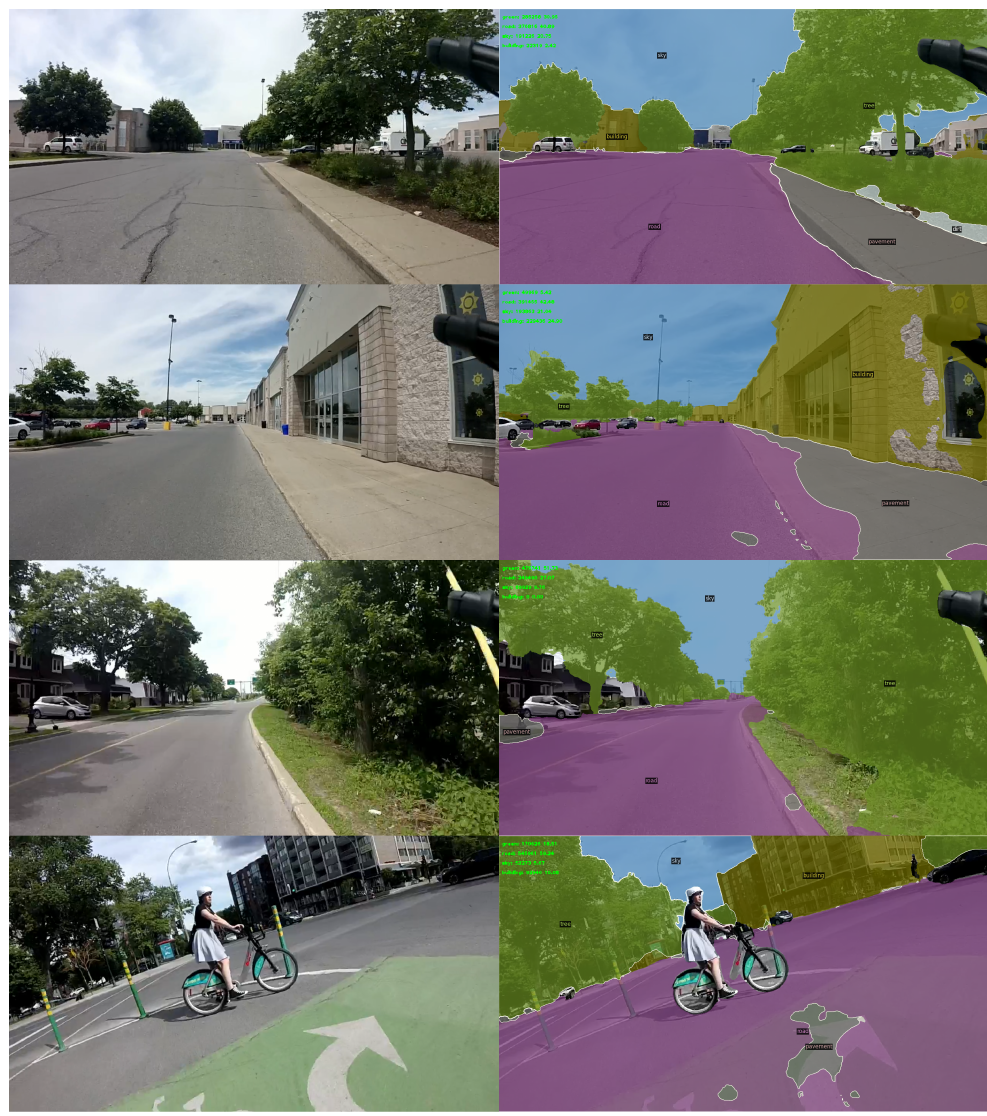
Figure 6. Detection of trees in different